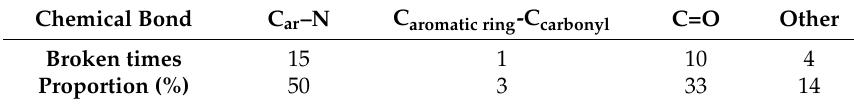
Table 1. Statistical results of the initially broken bond fractures for the 3-PMIA model. Chemical